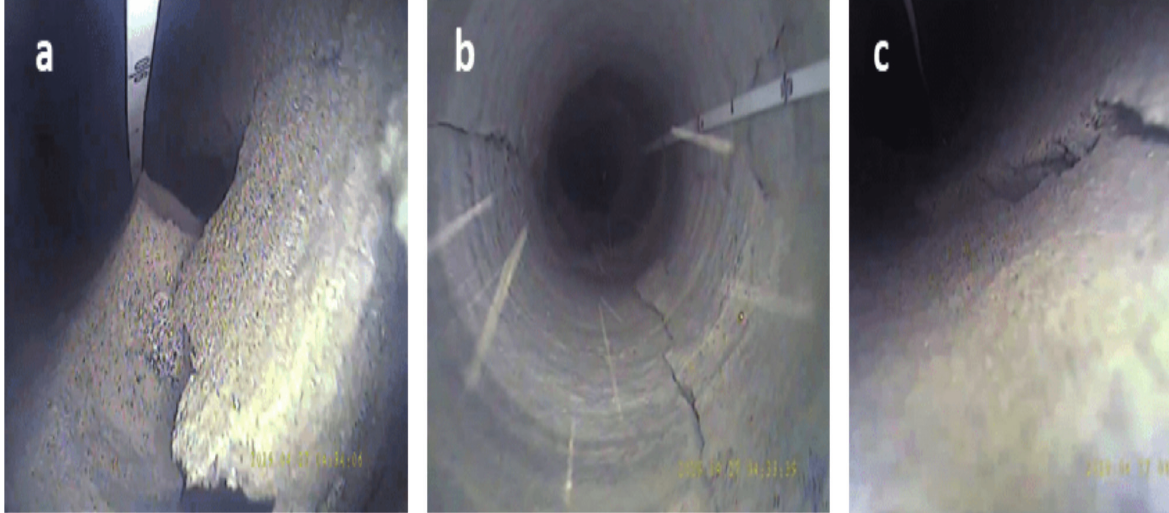
Figure 10. Images from the inspection holes of blast test 2. a has been made in the collapsed hole d, while b and c show the intense fracturing of hole e, both represented in Figure